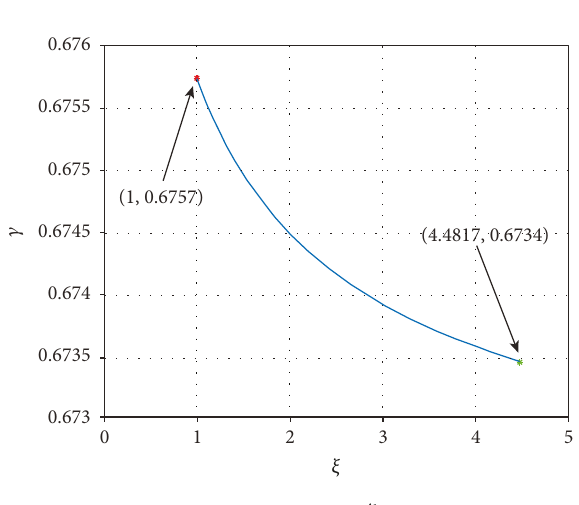
Figure 1: ξ versus α .